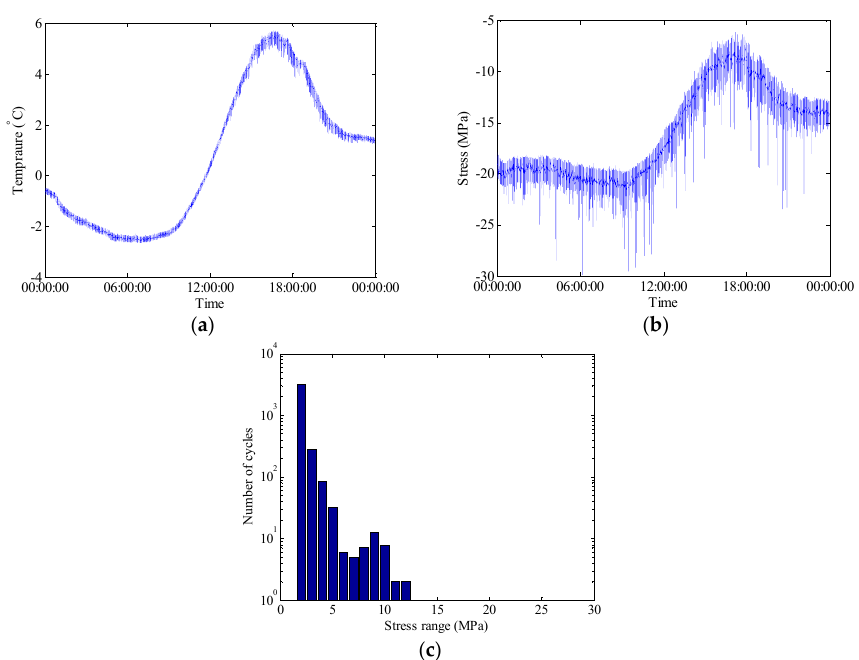
Figure 7. Raw data of selected FBG sensors during bridge operation phase on 29 December 2015: ( a ) Temperature time history measured by FBG-MS-NT-2; ( b ) Stress time history measured by FBG-MS-NS-2-3; ( c ) Histogram of daily stress